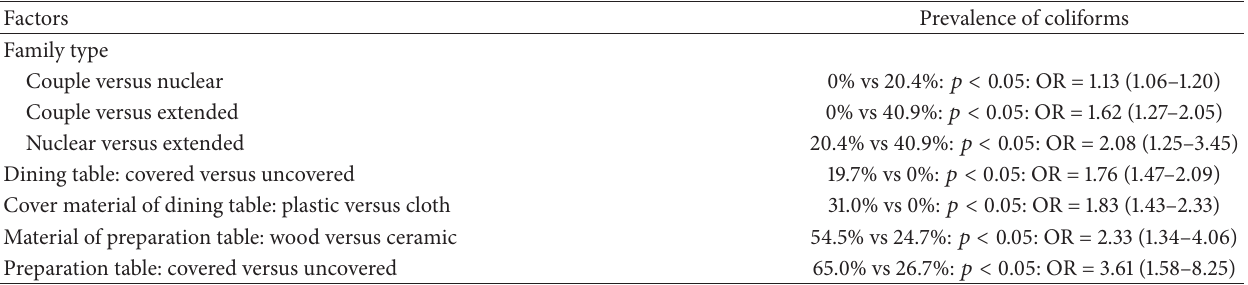
Table 3: Factors affecting prevalence of coliforms. Factors Prevalence of coliforms Family type